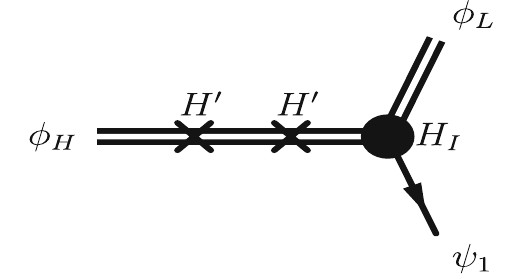
Fig. 5 The amplitudes A 1 α (left) and A 2 α (right) correspond to a neu- trino ψ 1 and ψ 2 respectively which is created from a single source particle φ H interacting with an environment in the state | α (cid:3) . If ψ 2 is heavier than ψ 1 , it will be slower at fixed momentum and so, given an